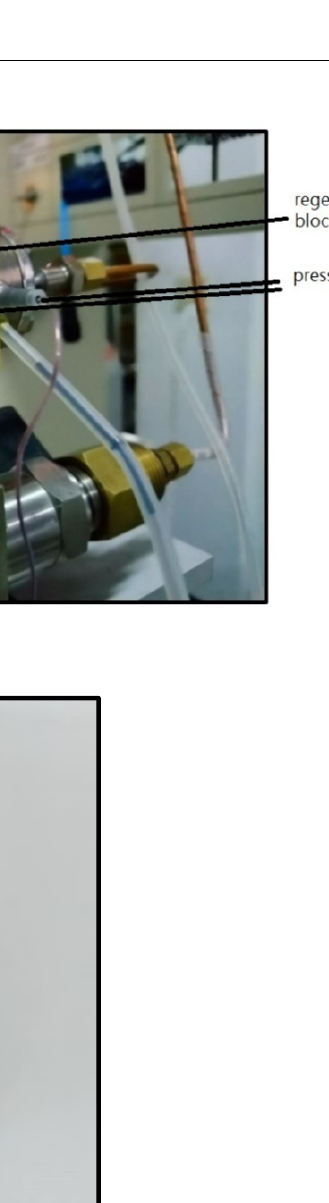
Table 2. Regenerator parameters.